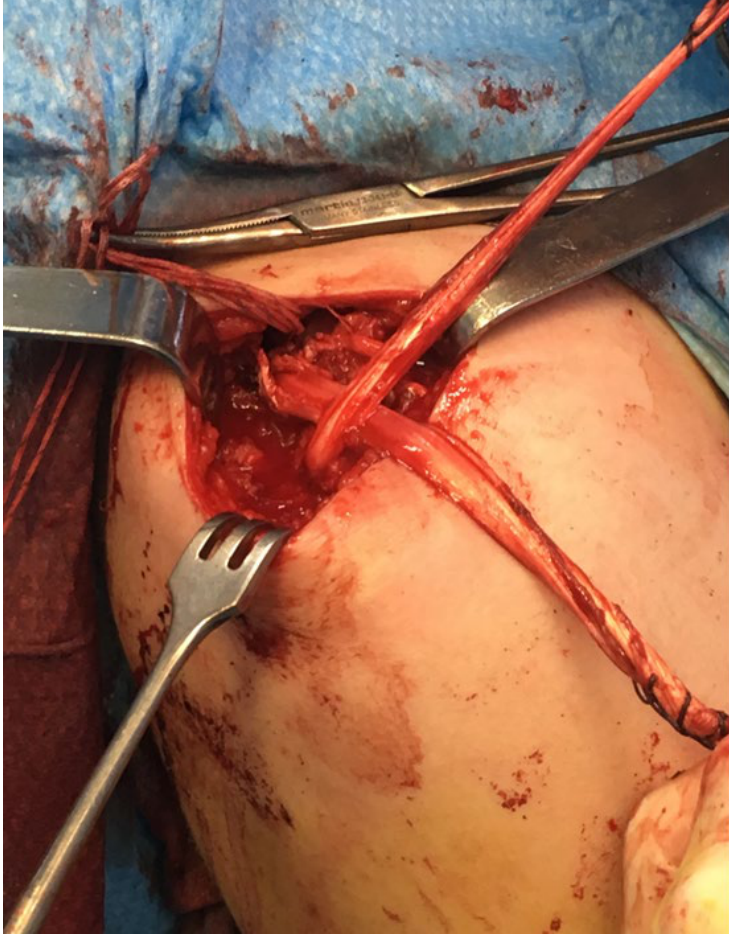
Figure 4. Intraoperative image of the tendon graft through the acromion and crossing the clavicle. The deltoid fascia was properly repaired after generous saline irrigation of the